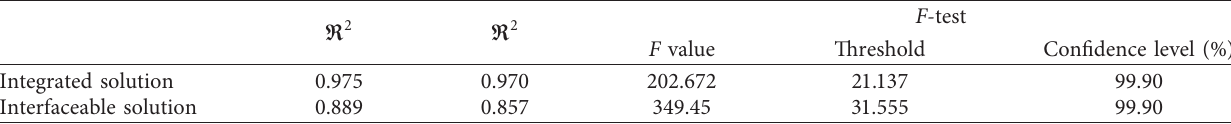
Table 5: Global statistical tests related to function f � f ( v ) in the case of network configuration 3. R 2 R